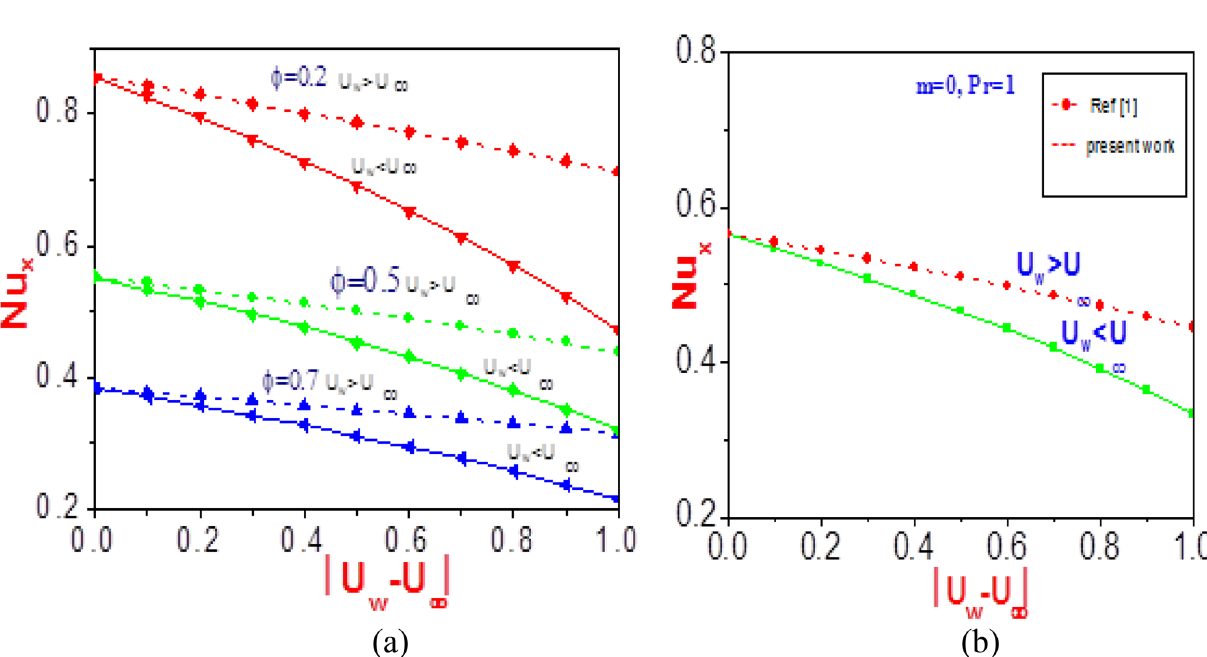
Figure 17. Profiles of Nusselt number versus normalized velocity difference ( a ) at different values of φ near the wall (η = 0 ) ( b ) for n = 1 and without nanoparticles [Ref. 46